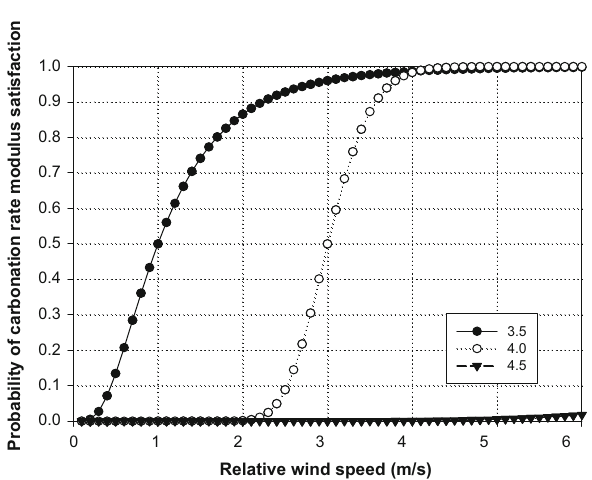
Fig. 11 Satisfaction Curve of sunlight exposure time param- eter for carbonation rate